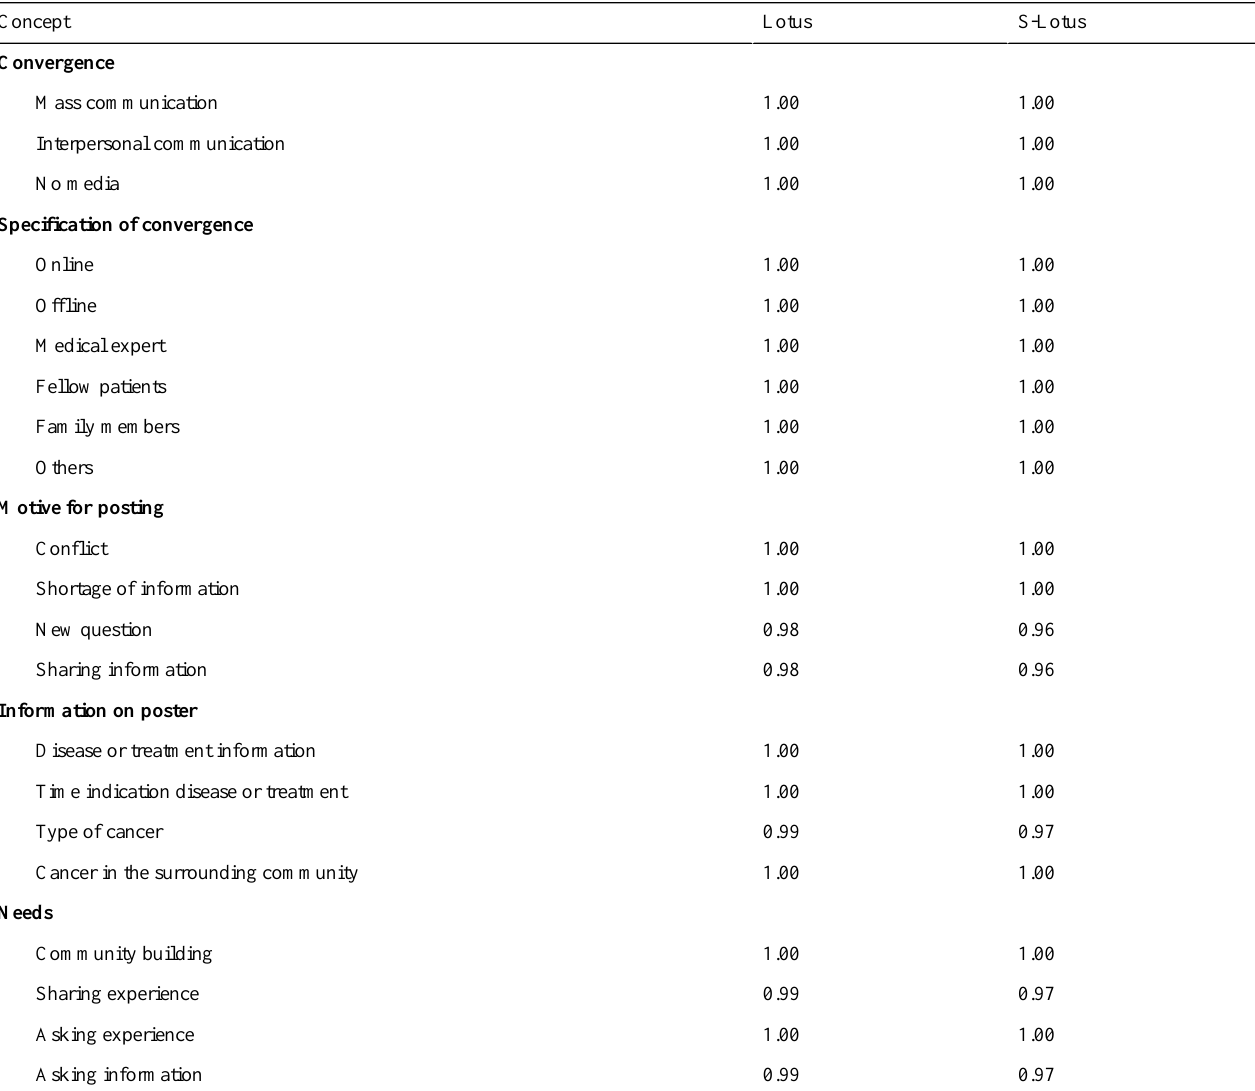
Table 2. Intercoder reliability using Lotus and standardized Lotus (S-Lotus) coefficients per variable.